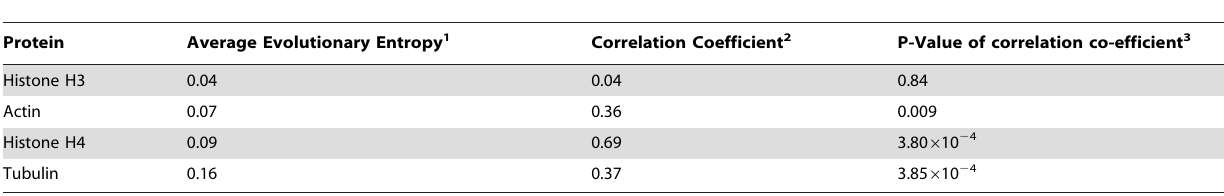
Table 3. Correlation between evolutionary entropy and Medusa entropy in highly conserved